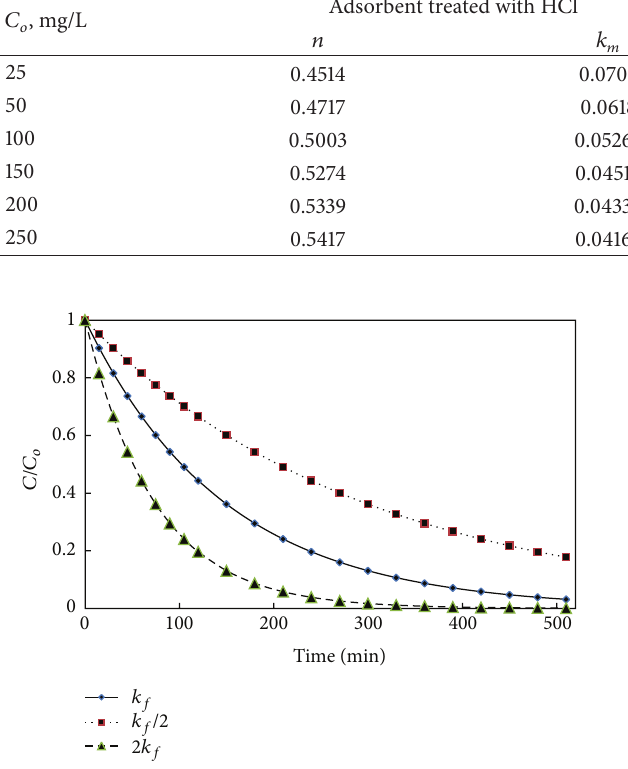
Figure 5: The plot of sensitivity analysis for showing the effect of 𝑘 𝑓 on the adsorption process for the adsorbent treated with HCl. Figure 6: The plot of sensitivity analysis for showing the effect of